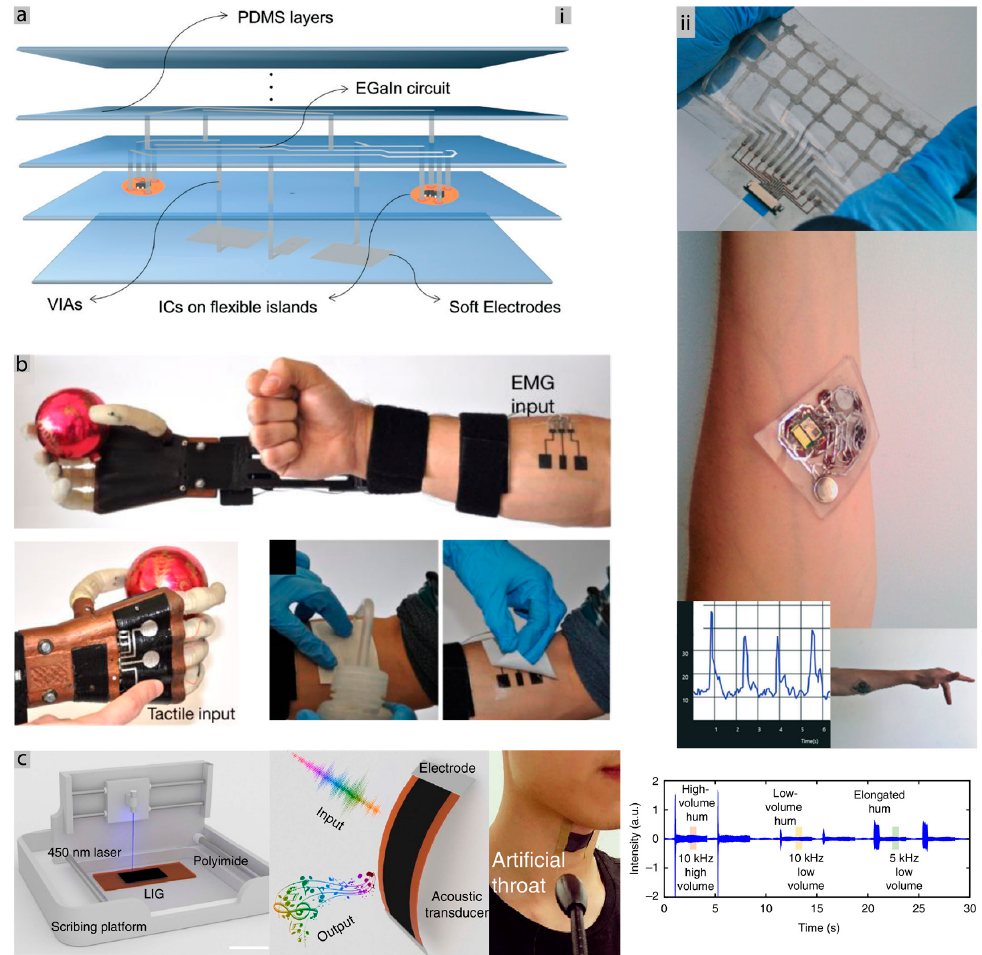
Figure 3. Examples of different approaches to the fabrication of bio-electronic wearables. ( a ) Multilayer stretchable patch with integrated microchips for electromyography (EMG) monitoring. (i) layer-by-layer schematics. (ii) Real applications. Adapted with permission from [108]. ( b ) ultrathin, printed electronic tattoo transferred over the forearm as an EMG input to control prosthetic hands, and as well transferred on the shield of a prosthetic hand as a tactile input. Adapted with permission from [85]. ( c ) Laser one-step induced graphene flexible sensor and transducer, capable of sound detection and sound emission. Due to the implementation of an artificial intelligence system, it has the capability of working as an artificial throat, translating hum sounds into speech. Adapted with permission from [97].